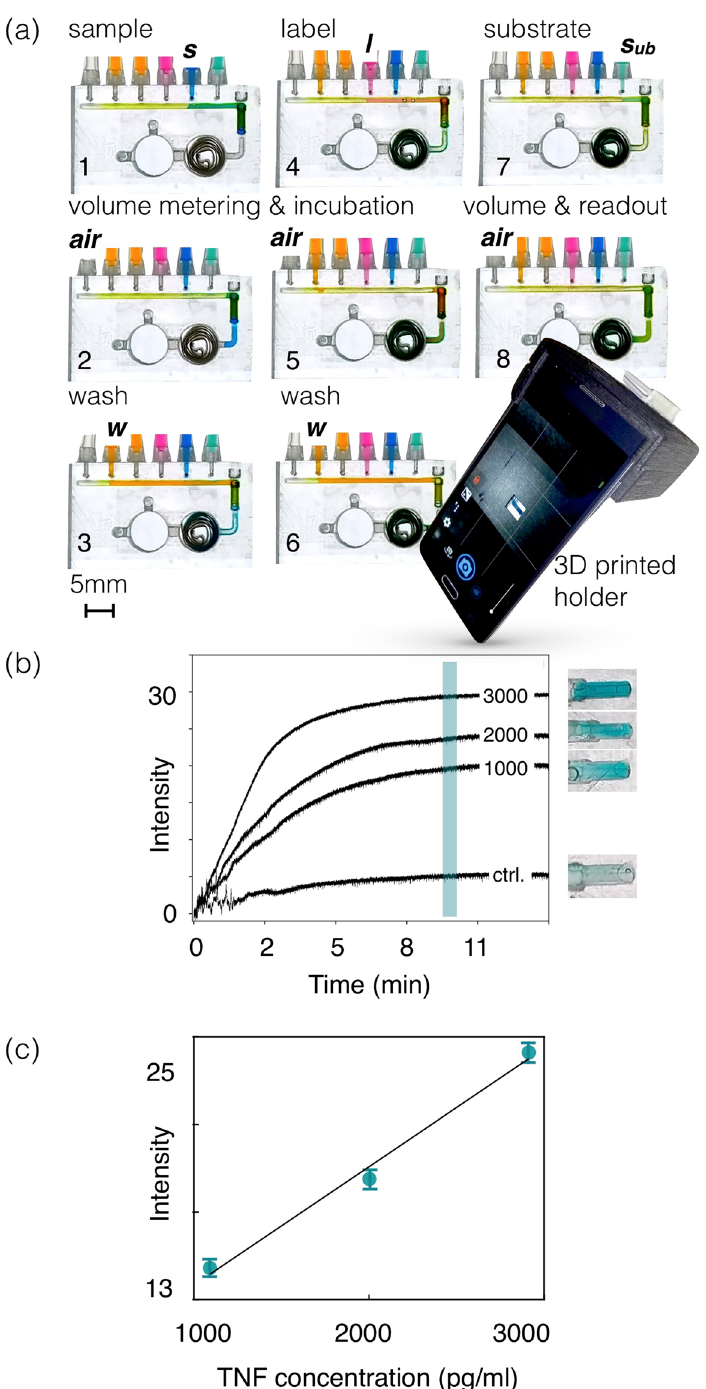
Figure 3. ( a ) Sequence of operations for a sandwich ELISA protocol as implemented in the proposed device. ( b ) Dynamic response of a commercial TNF ELISA assay video recorded at 30 fps. ( c ) Quantification of commercial TNF-ELISA for different analyte concentrations. Error bars correspond to 95% confidence